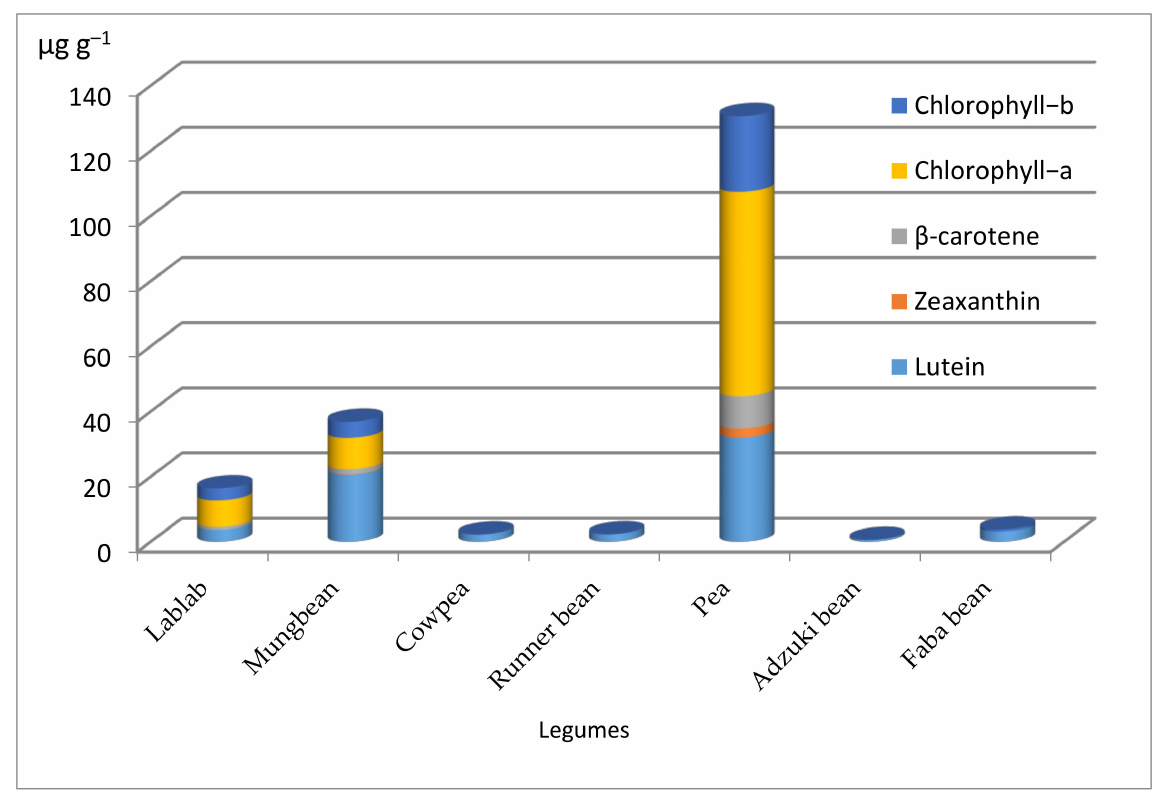
Figure 4. Carotenoid and chlorophyll concentrations in different legume seeds. Lablab ( Lablab purpureus ), Mungbean ( Vigna radiata ), Cowpea ( Vigna unguiculata ), Runner bean ( Phaseolus multiflorus ), Pea ( Pisum sativum ), Adzuki bean ( Vigna angularis ), and Fababean ( Vicia faba